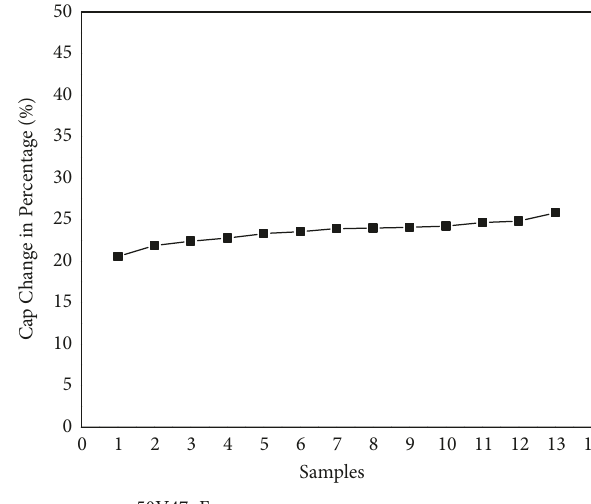
Figure 1: Capacitance change in percentage at 125 ∘ C without water wash process for polymer tantalum capacitors with 15,000 𝜇 C/g anodes 153V formation for 63V33 𝜇 F and 23,000 𝜇 C/g anodes 124V formation for 50V47 𝜇 F.